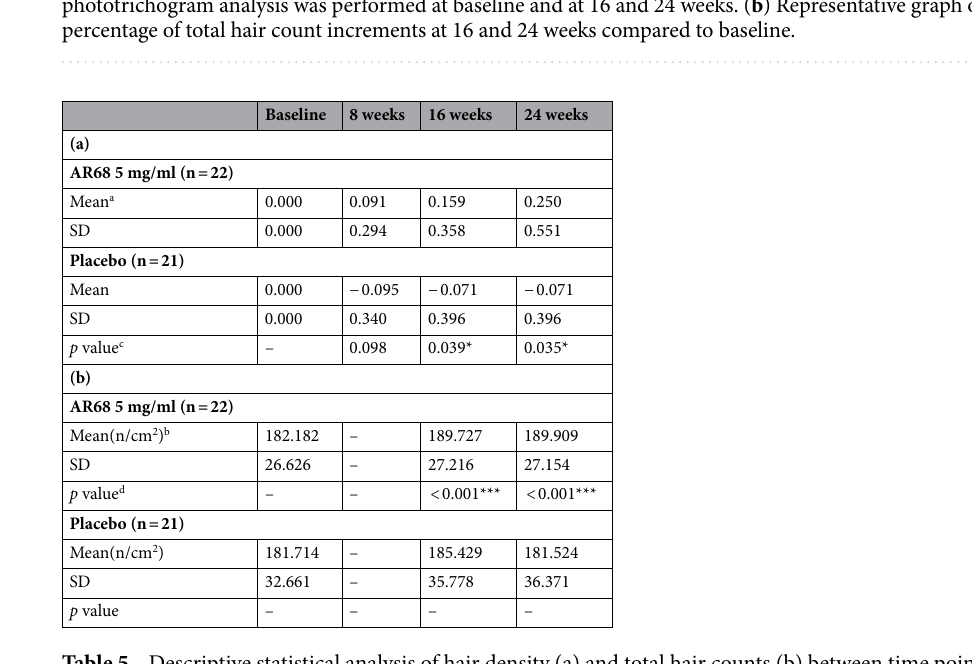
Table 5. Descriptive statistical analysis of hair density (a) and total hair counts (b) between time points in clinical study II. a Increment of mean value represents improvement of hair condition on hairline and vertex. b Increment of mean value represents improvement of hair counts. c Significantly different at * p < 0.05 compared with AR68 5 mg/ml treated group and placebo group at same time point. d Significantly different at *** p < 0.001 compared with